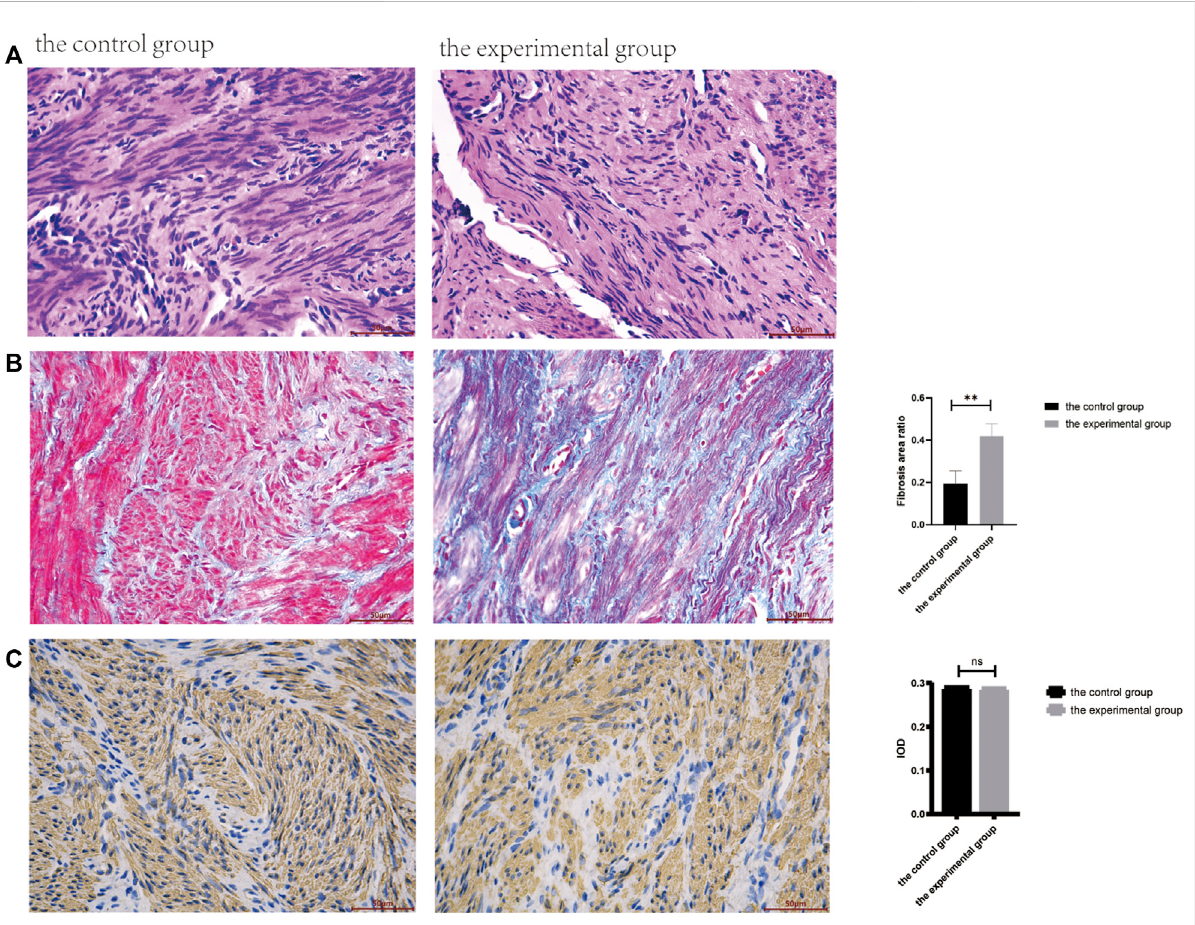
Pathological and immunohistochemical results between the control and the experimental groups. (A) . The HE staining (400 ⅹ ). (B) . The Masson staining (400 ⅹ ), the fi brosis area was calculated by ImageJ software, and there was signi fi cant statistical difference between the two groups (** p < .01). (C) . Immunohistochemical staining of smooth muscle speci fi c marker α -SMA was compared between the two